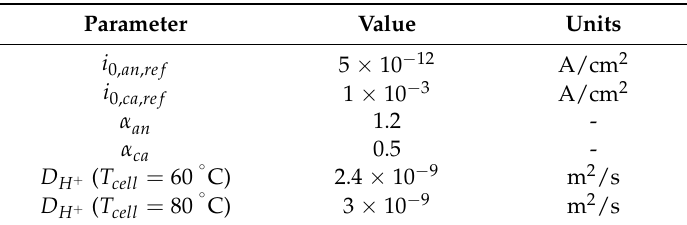
Table 4. Fitted model parameters.